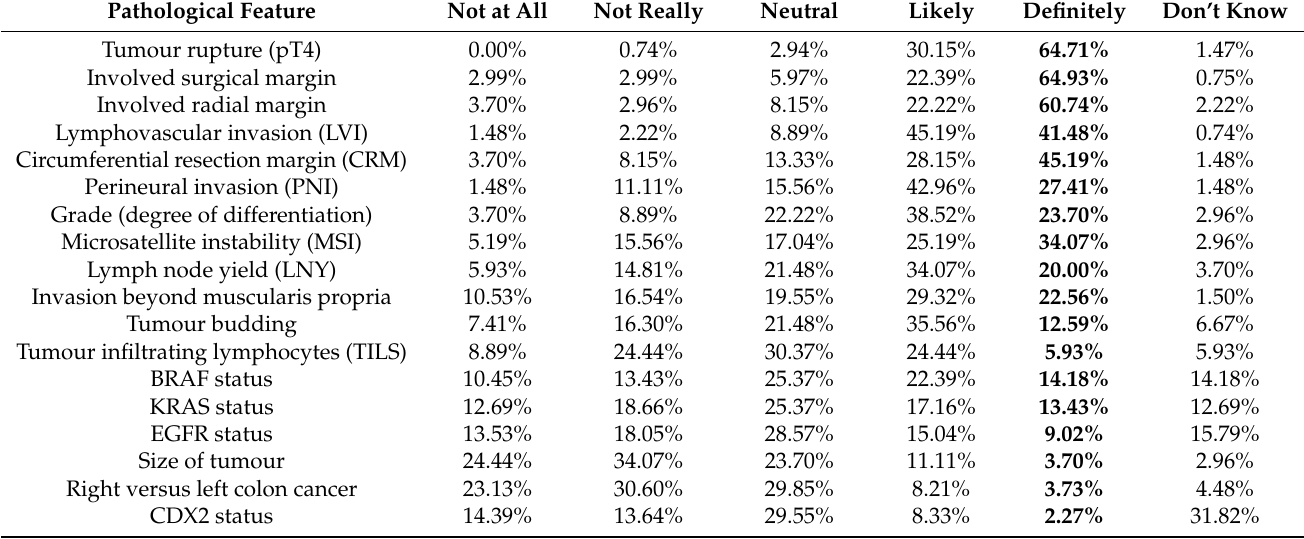
Table 2. Likert score table for specialist responses to whether pathological feature influence decision- making in guiding adjuvant treatment in stage II colon cancer. Adapted from Wiley Cancer